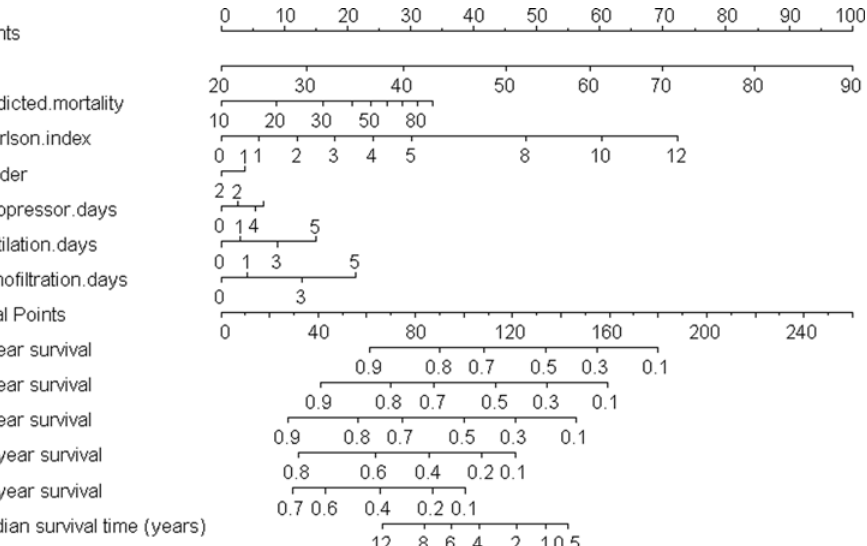
Figure 5. Nomogram for predicting long-term survival probabilities and median survival time. Note: gender: 2=female, 1=male. Predicted.mortality=APACHE II predicted mortality in